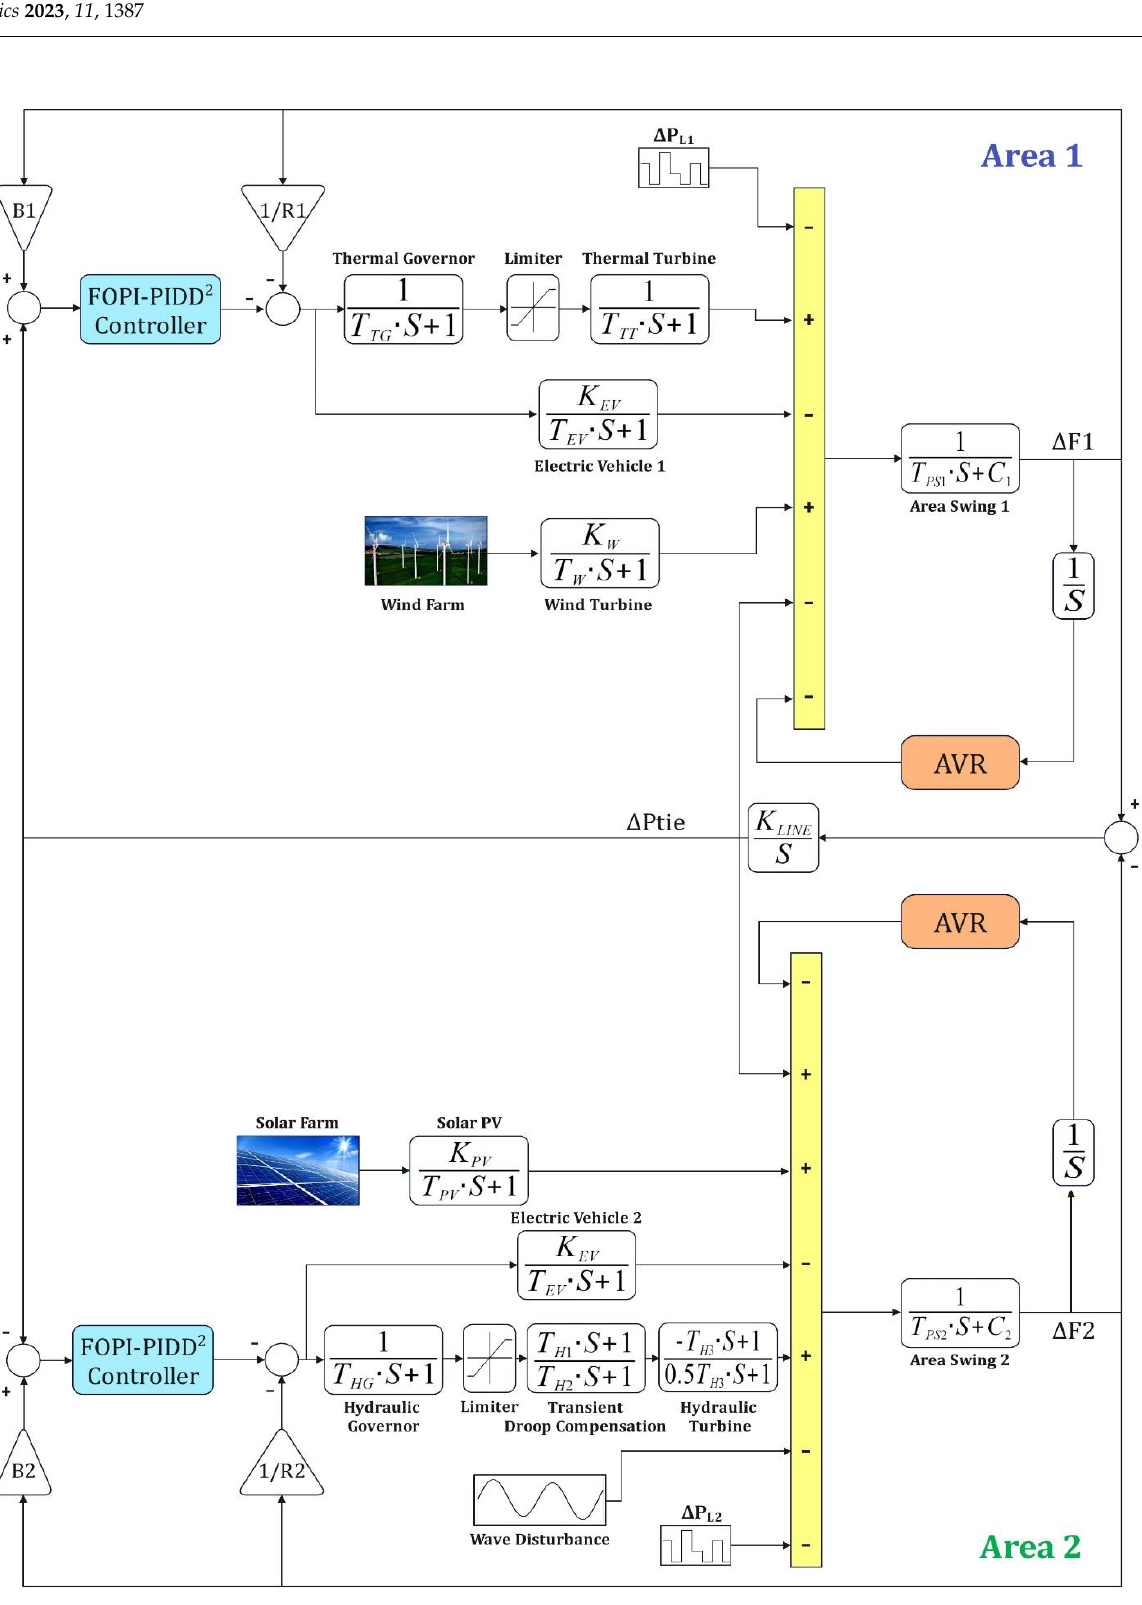
Figure 14. The investigated hybrid two-area system model with the suggested